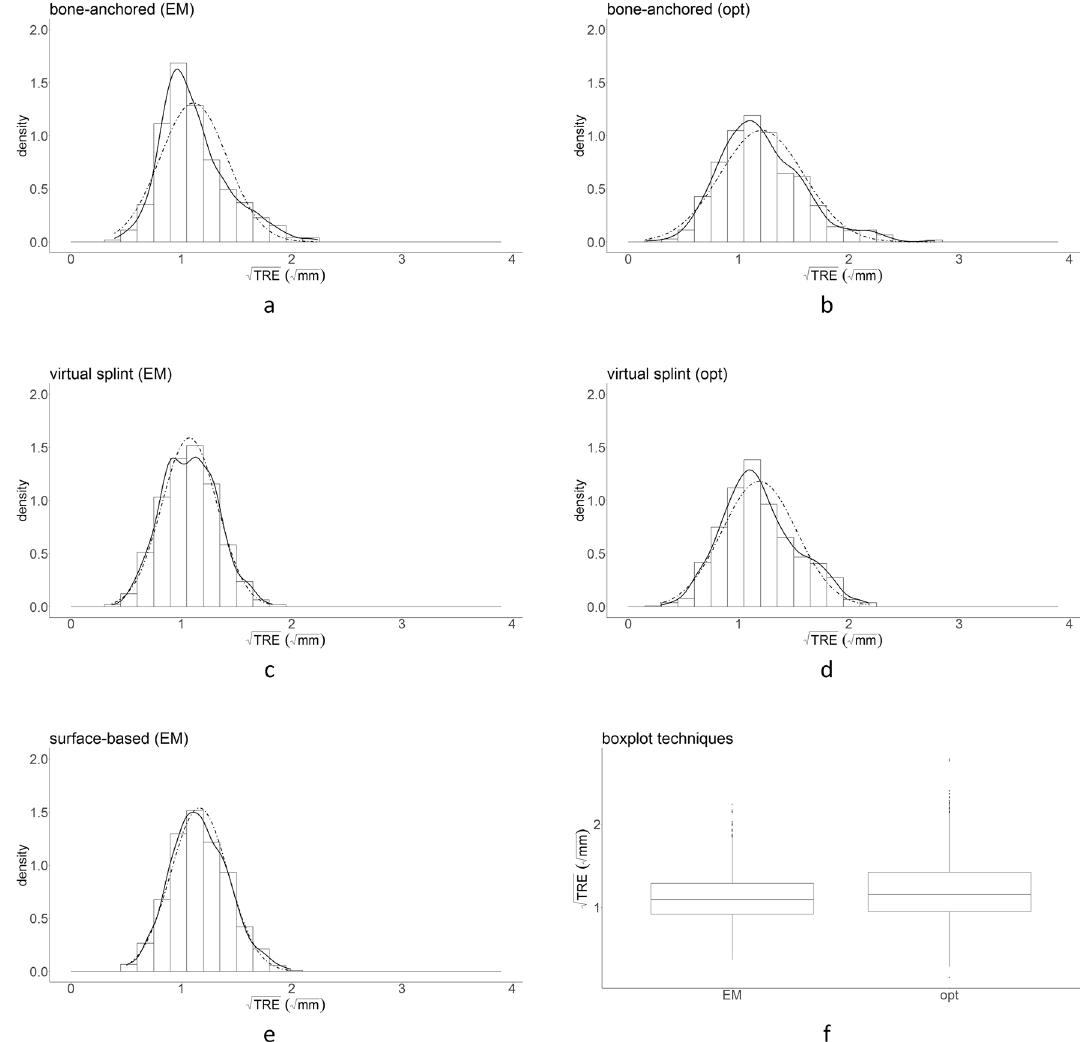
Figure 4. Distribution of √ TRE for each combination of tracking technique and registration method ( a – e ), and the box and whisker plots ( f ). The distribution of the data corresponds better to a normal distribution after the data correction.